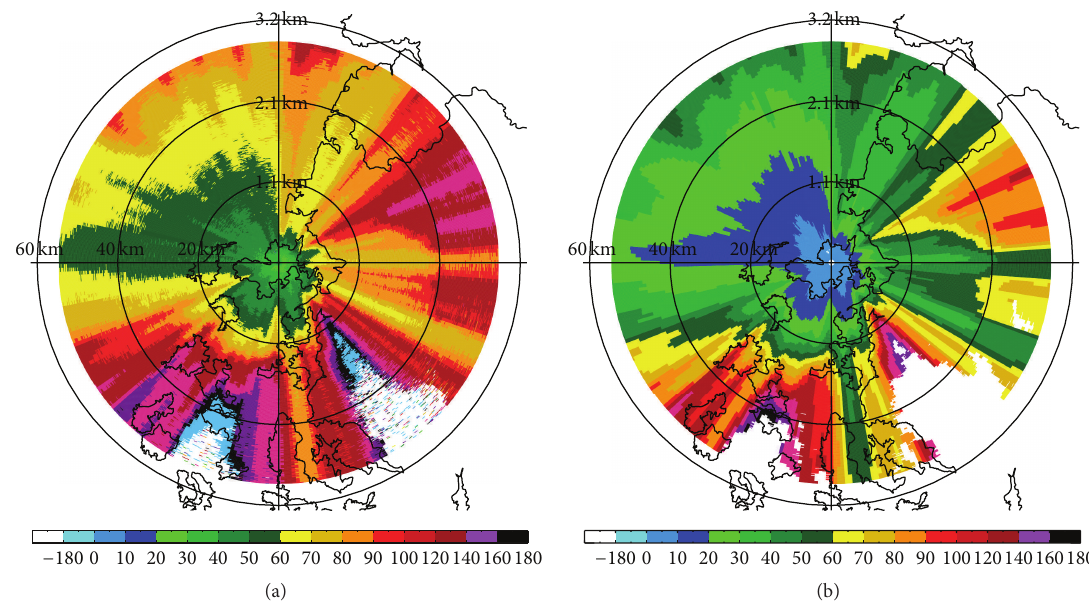
Figure 5: PPIs of measured (a) and filtered (b) Ψ